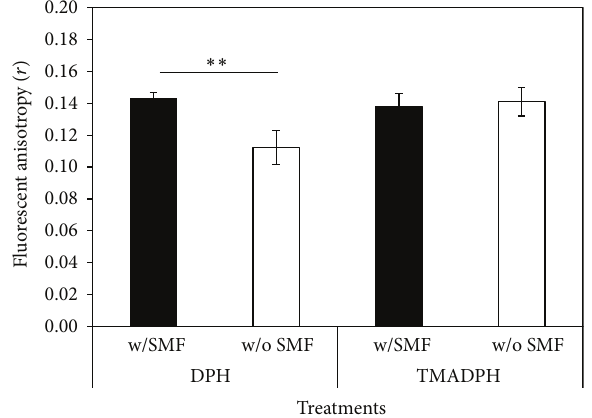
Figure 9: Comparison of fluorescent anisotropy change in DPCs exposed to 0.4 TSMF. Higher fluorescent anisotropy of SMF- exposed cells was found when labeled with